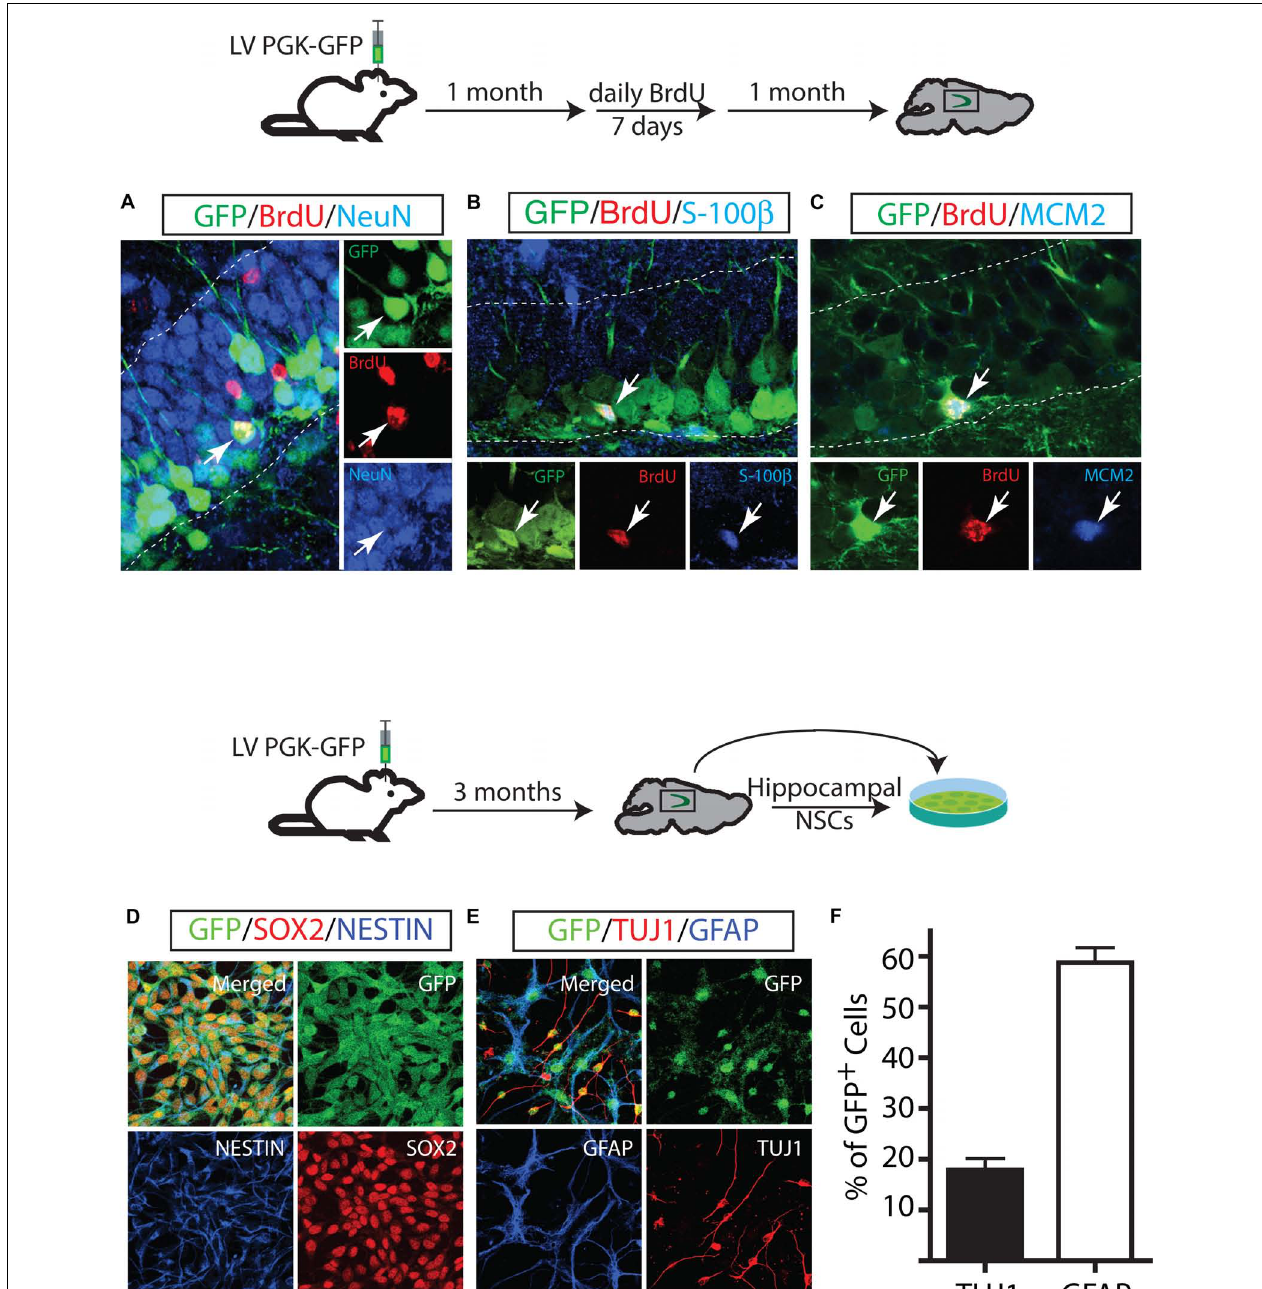
FIGURE 3 | Long-term maintenance of NSCs in the adult hippocampus. Fate mapping of GFP + identified NSCs that proliferate and produce neurons (A) and astrocytes (B) . Some NSCs underwent cell proliferation proliferated twice in a one-month interval (C) . GFP-labeled cells in vivo gave rise to in vitro NSCs. In vitro , GFP + NSCs expressed NSC markers such as NESTIN and Sox2 (D) and differentiated into neurons (TUJ1) and astrocytes (GFAP) (E) . GFP + derived-neurons and astrocytes at day 7 of differentiation (F) .